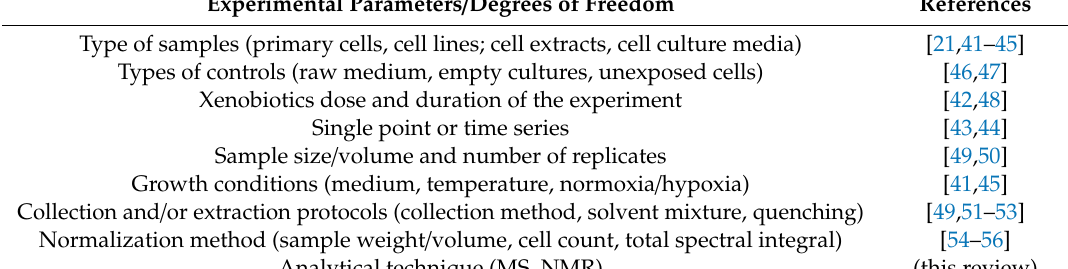
Table 1. Key aspects to consider for the experimental design and recommended bibliographic references. Experimental Parameters / Degrees of